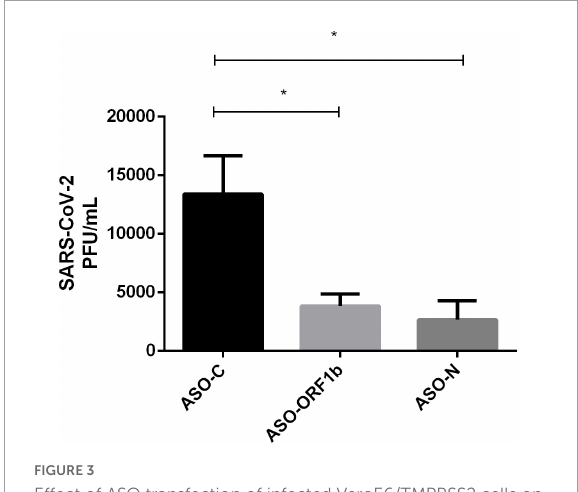
FIGURE3 Effect of ASO transfection of infected VeroE6/TMPRSS2 cells on viral titer by PFU assay. ASO-ORF1b and ASO-N significantly reduced viral replication in infected VeroE6/TMPRSS2 cells ( p < 0.05). In comparison to ASO-C, the reduction in viral production reached 71–80% for ASO-ORF1b and ASO-N, respectively. There was no significant difference between these two ASO gapmers. (* p < 0.05).